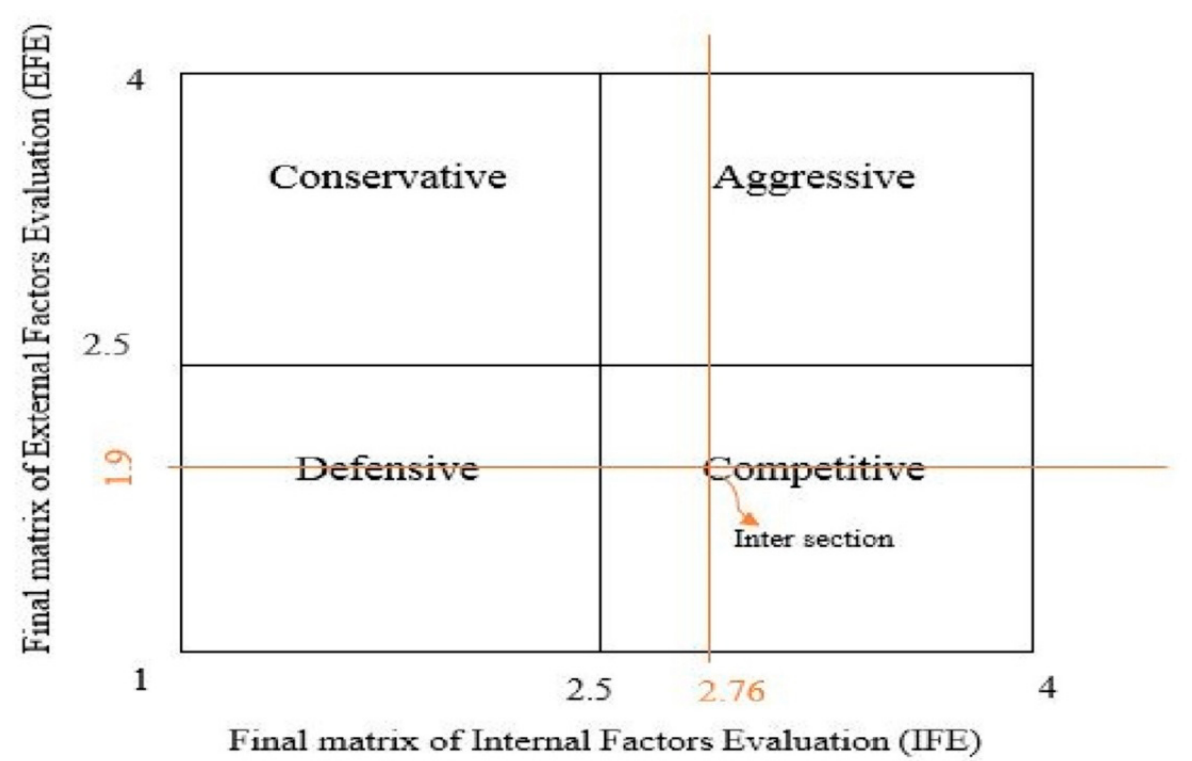
Figure 4. SWOT matrix with final marks obtained from evaluating an internal and external IE Matrix shows that Zone 1 is located in the ‘competitive-strategy’ quadrant, i.e., for this zone we should appoint strategies that capitalize on the strengths of the city which ensure security against environmental threats.